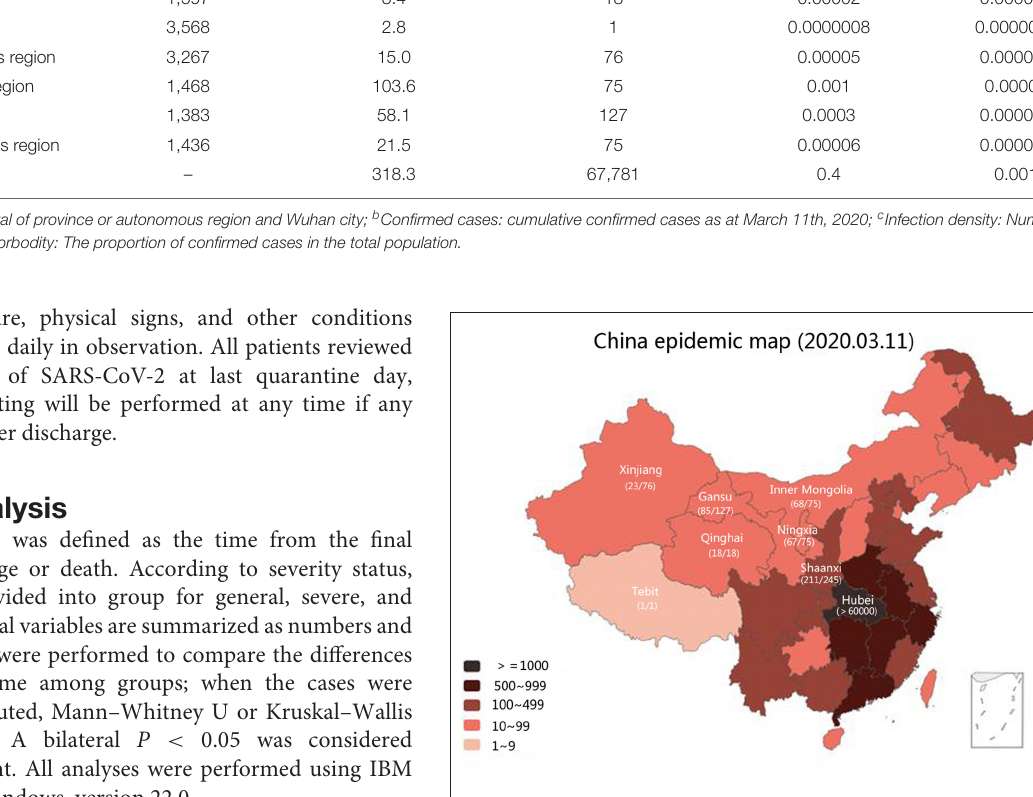
FIGURE 1 | Northwestern China and the epidemic map of